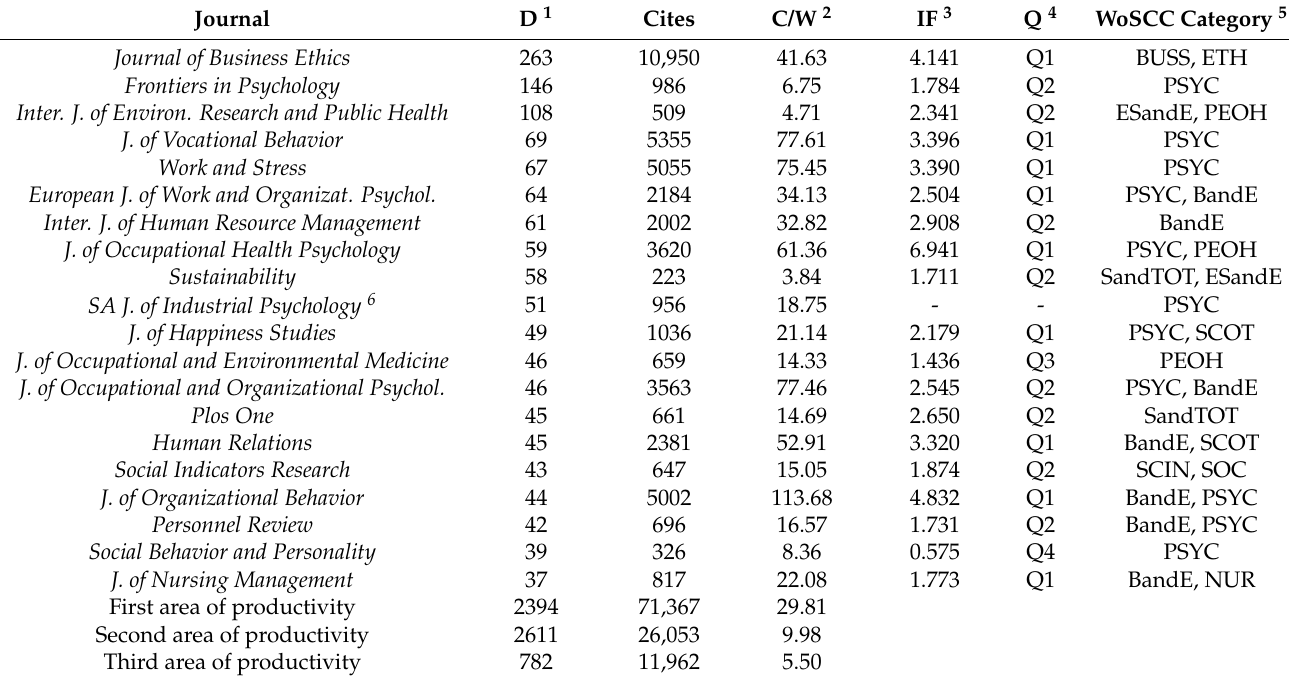
Table 2. Journals that have published the most works in